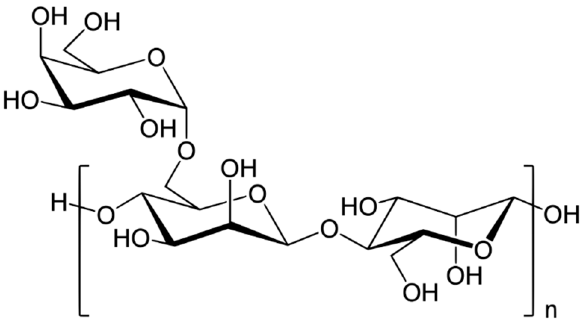
Figure 9. Chemical structure of xanthan.